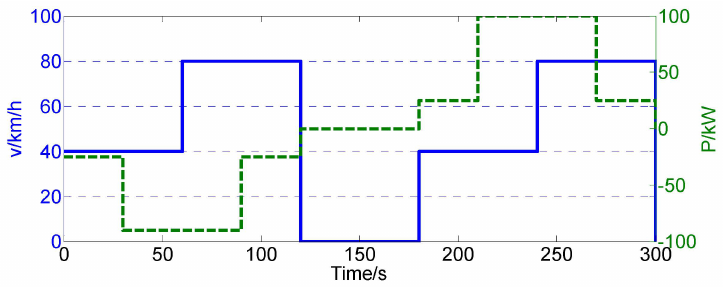
Figure 26. The experimental conditions of the HESS